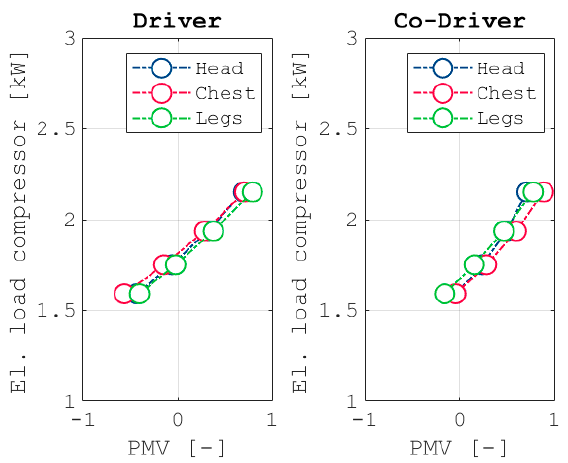
Figure 14. Electrical load of the compressor vs. the PMV value: ( left ) driver; ( right ) co-driver.